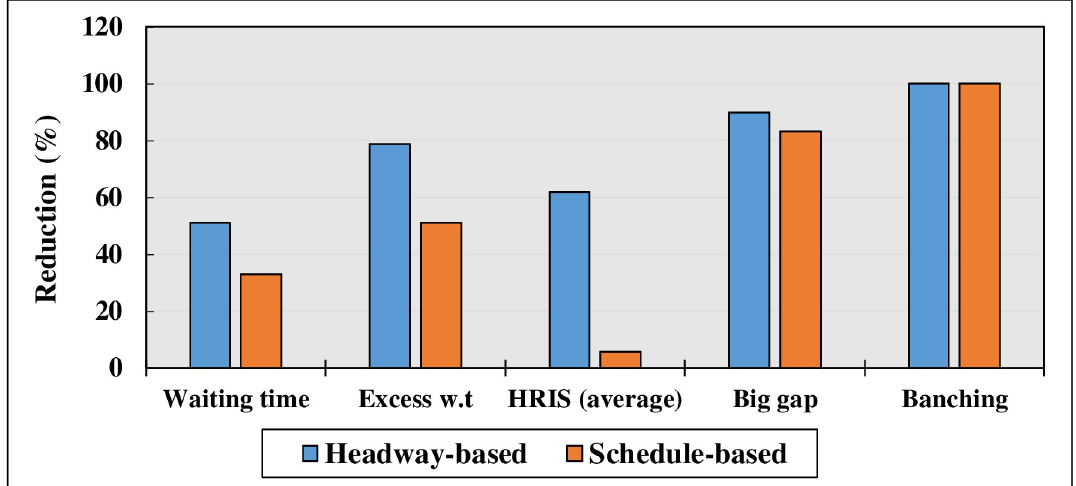
Fig 7. Comparison of headway-based and schedule-based dispatching strategies.